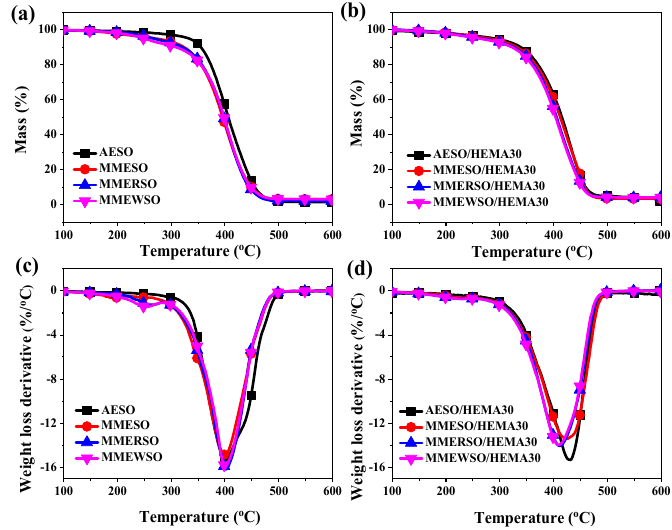
Figure 4. TGA curves ( a,b ) and their derivatives ( c,d ) of the UV-cured EA-like materials.